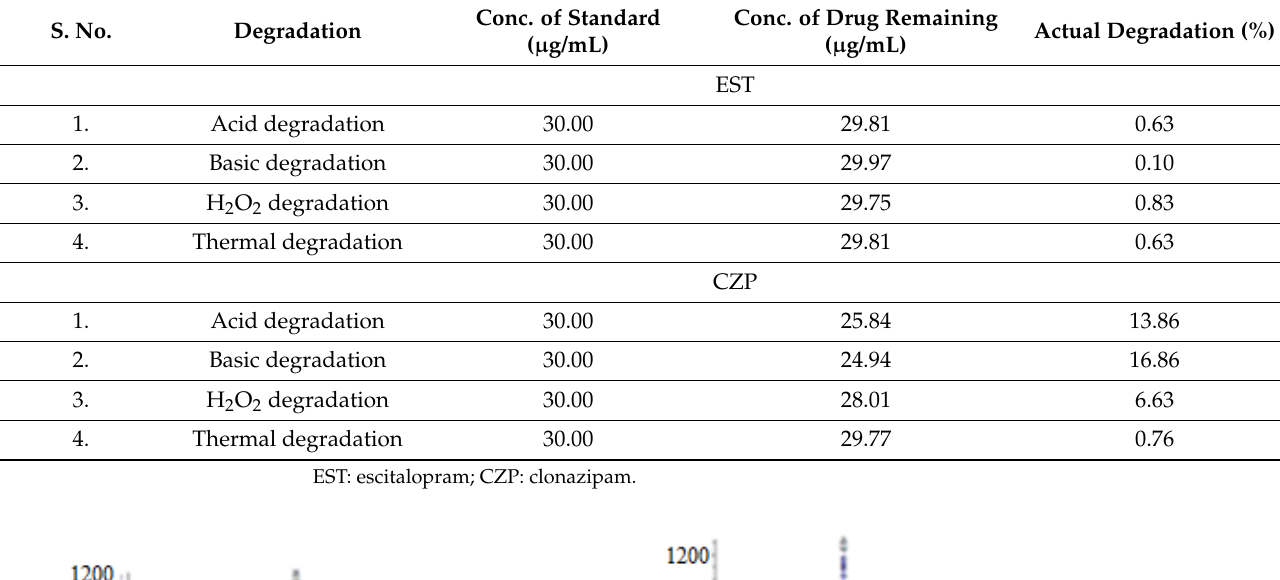
Table 5. Results of forced degradation studies.